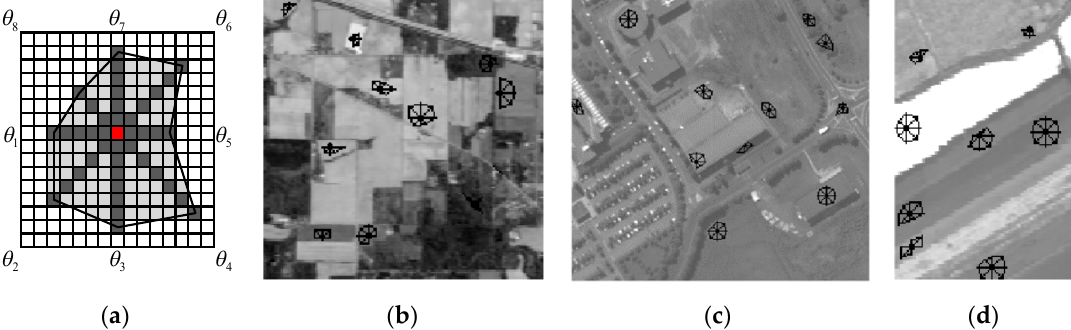
Figure 1. ( a ) Diagram of an example shape adaptive (SA) region. The red block denotes the central pixel, the dark gray block denotes the length in the eight directions, and the light gray block denotes the SA neighborhood; ( b – d ) are examples of the SA neighborhood for the Indian Pines data, part of the Pavia University data and part of the Salinas Valley data, respectively.